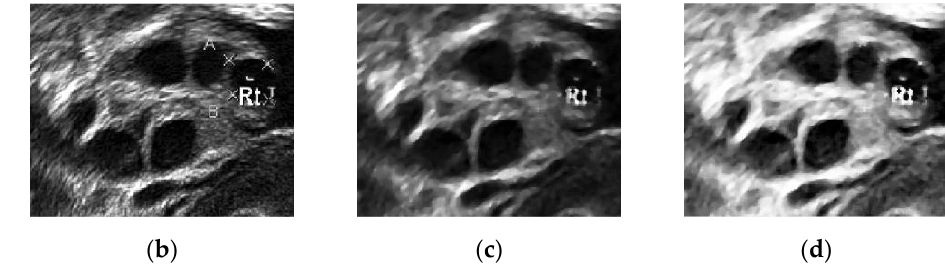
Figure 10. ( a ) Original ultrasound image, ( b ) ultrasound image after contrast enhancement, ( c ) ultrasound image with median filter, and ( d ) ultrasound image after histogram equalization.